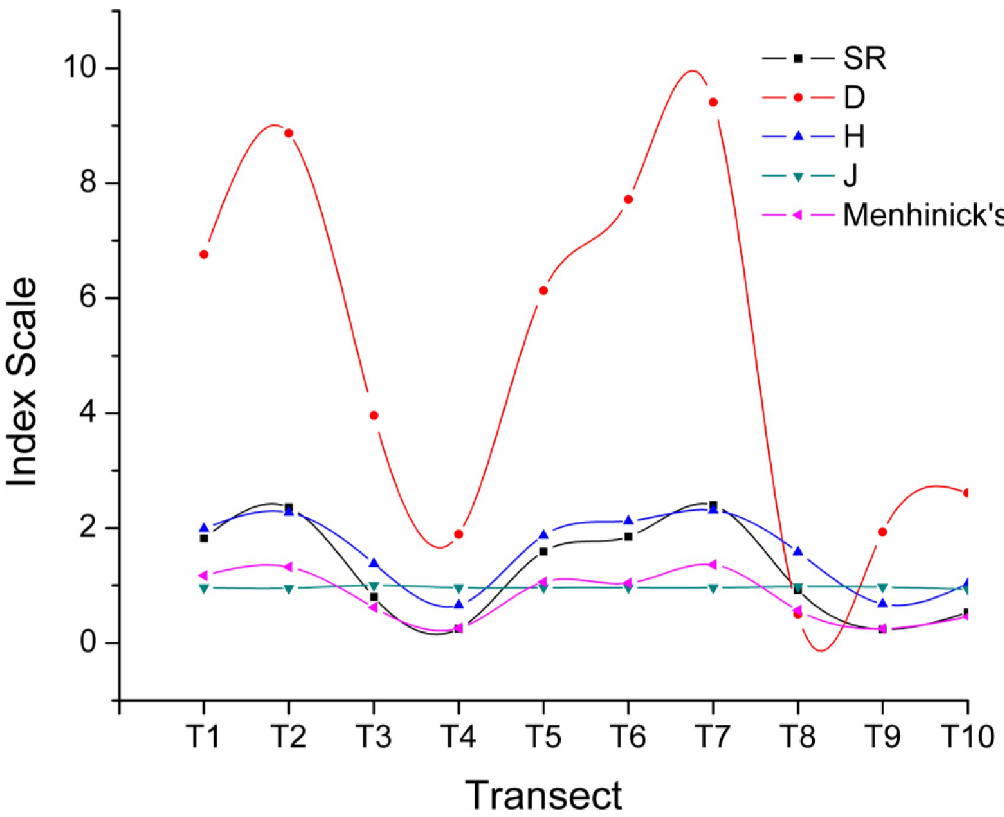
Fig 5. Transect-wise graphical representation of diversity